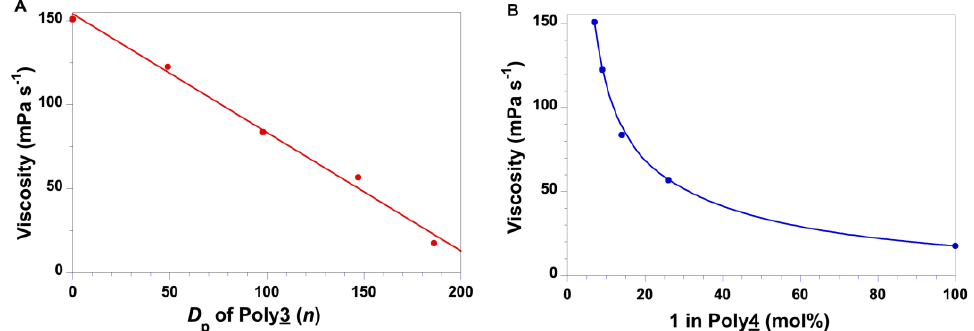
Figure 4. Relationships between the viscosity (mPa s − 1 ) and ( A ) D p of Poly 3 ( n ) and ( B ) the compo- sition ratio of 1 in the Poly 4 domain of Poly 1 (mol%) at a shear rate of 100 s − 1